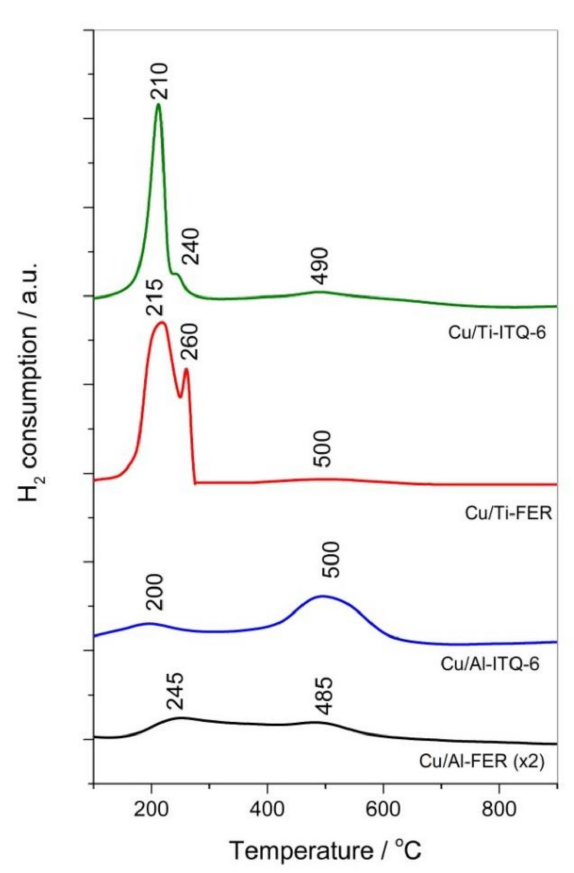
Figure 5. H 2 -TPR profiles of ferrierite and ITQ-6 zeolites modified with